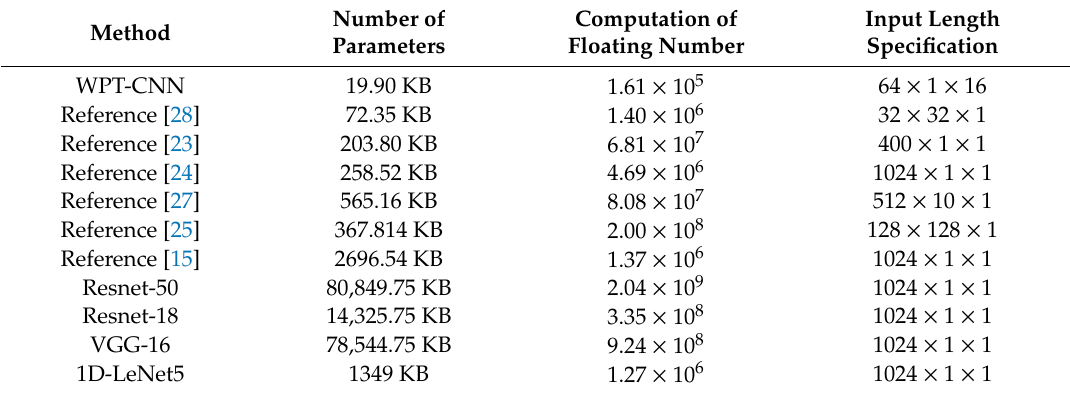
Table 3. Comparison of networks in terms of the parameters and computational